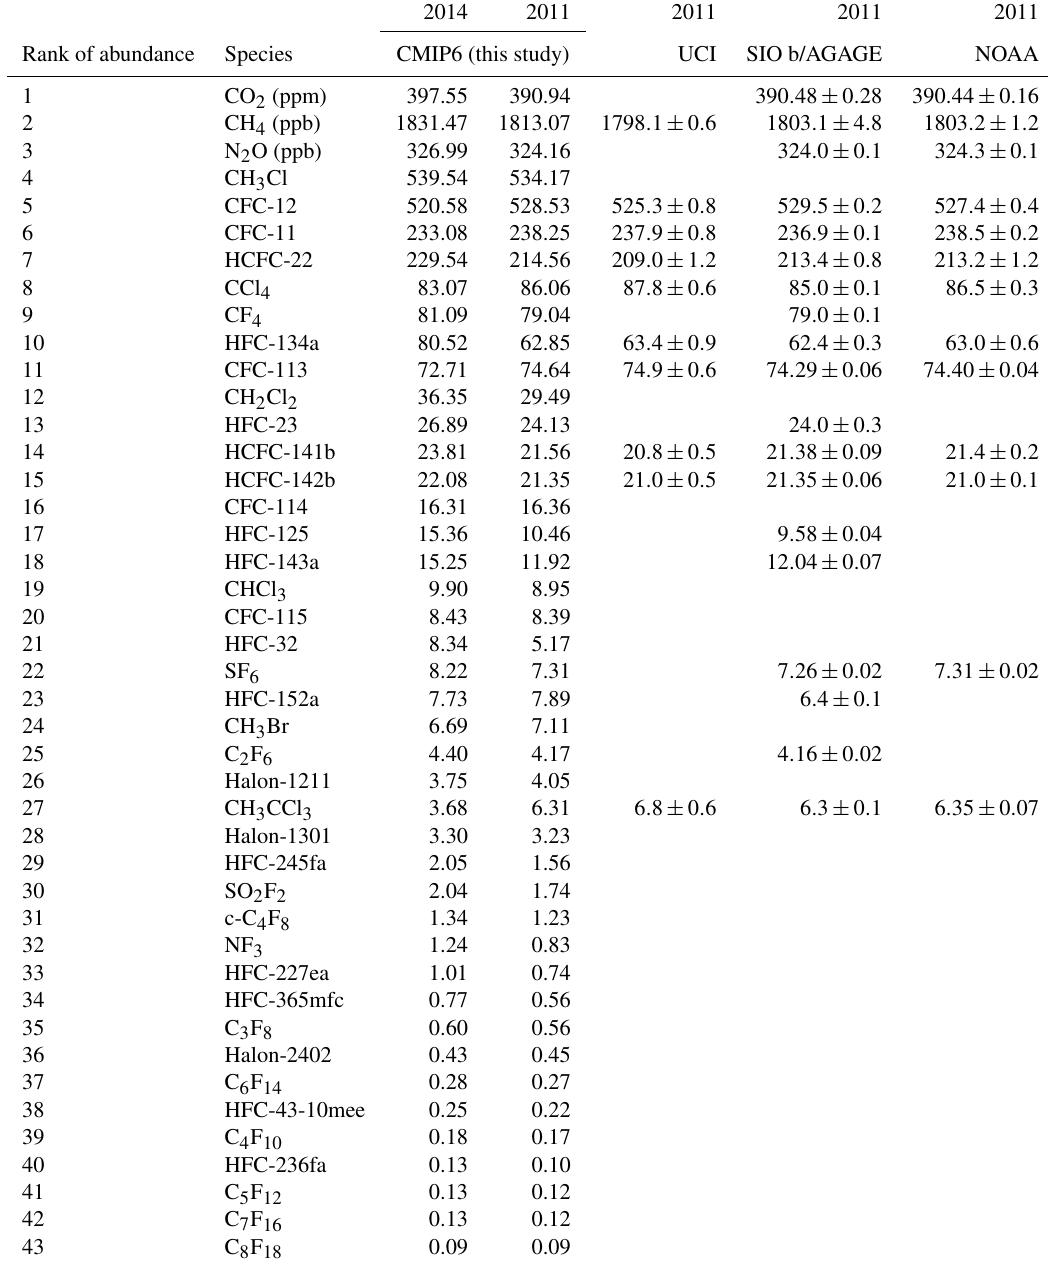
Table 7. Global- and annual-mean GHG surface concentrations for year 2011 and 2014, including a comparison to 2011 NOAA, AGAGE and UCI estimates – as provided in IPCC AR5 WG1. Unit is parts per trillion (ppt), unless otherwise